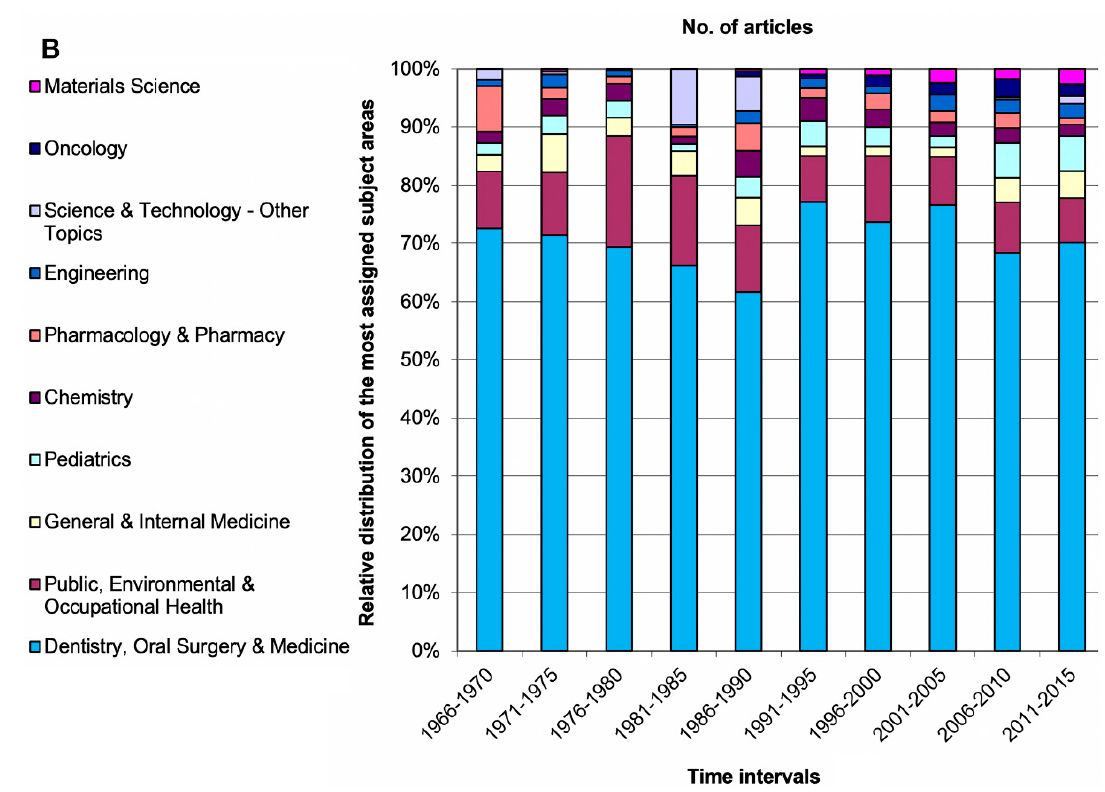
Figure 5. Subject areas of Web of Science categories. ( A ) Ten most frequently assigned areas with number of articles and citations. ( B ) Relative distribution of the most frequently assigned subject areas in 5-year intervals from 1966–2015.